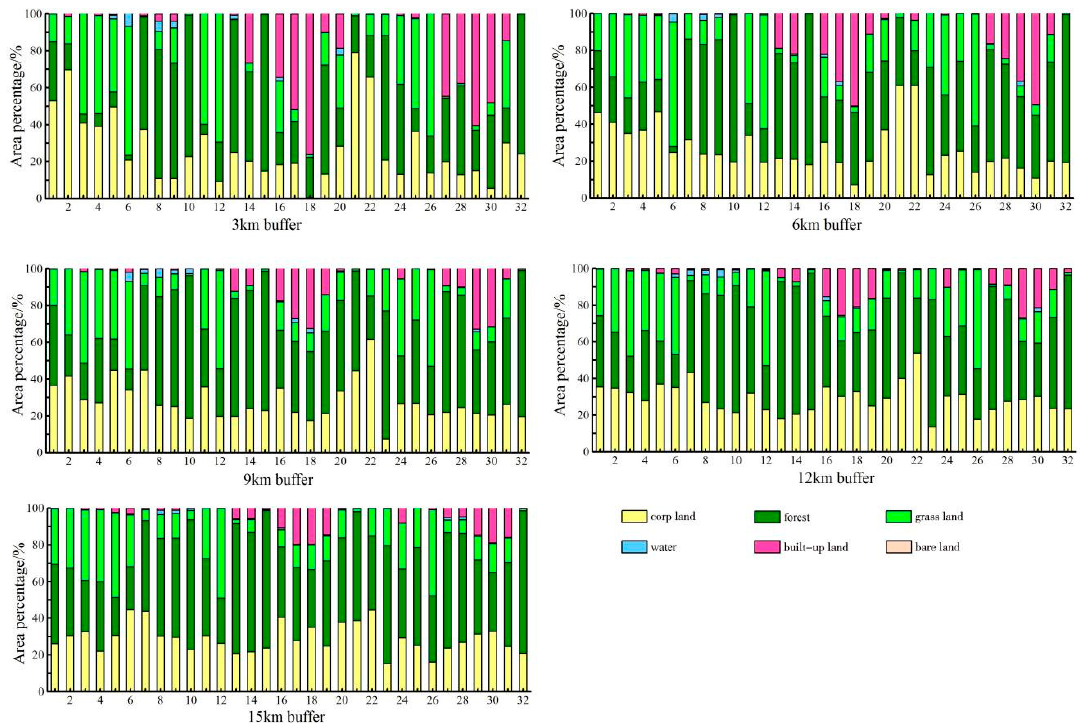
Figure 4. Landscape composition characteristics for Wujiang river watershed at five buffer scales.